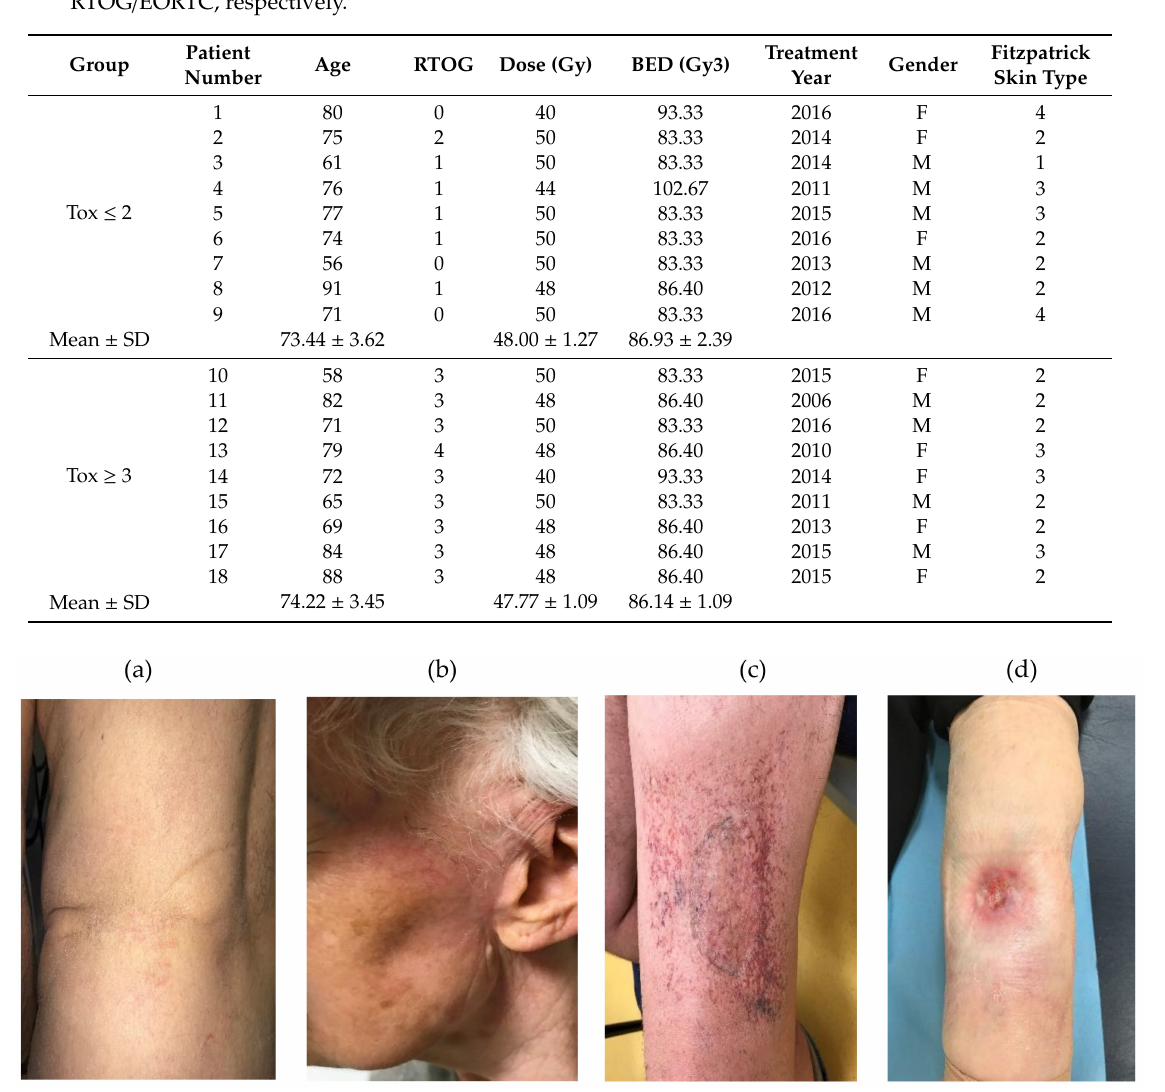
Figure 1. Pictures of some patient irradiated skin regions: ( a ) patient with grade 0 toxicity (no fibrosis, no telangiectasia); ( b ) patient with grade 1 toxicity (no fibrosis, imperceptible telangiectasia); ( c , d ) patients with grade 3 toxicity (pronounced fibrosis, marked